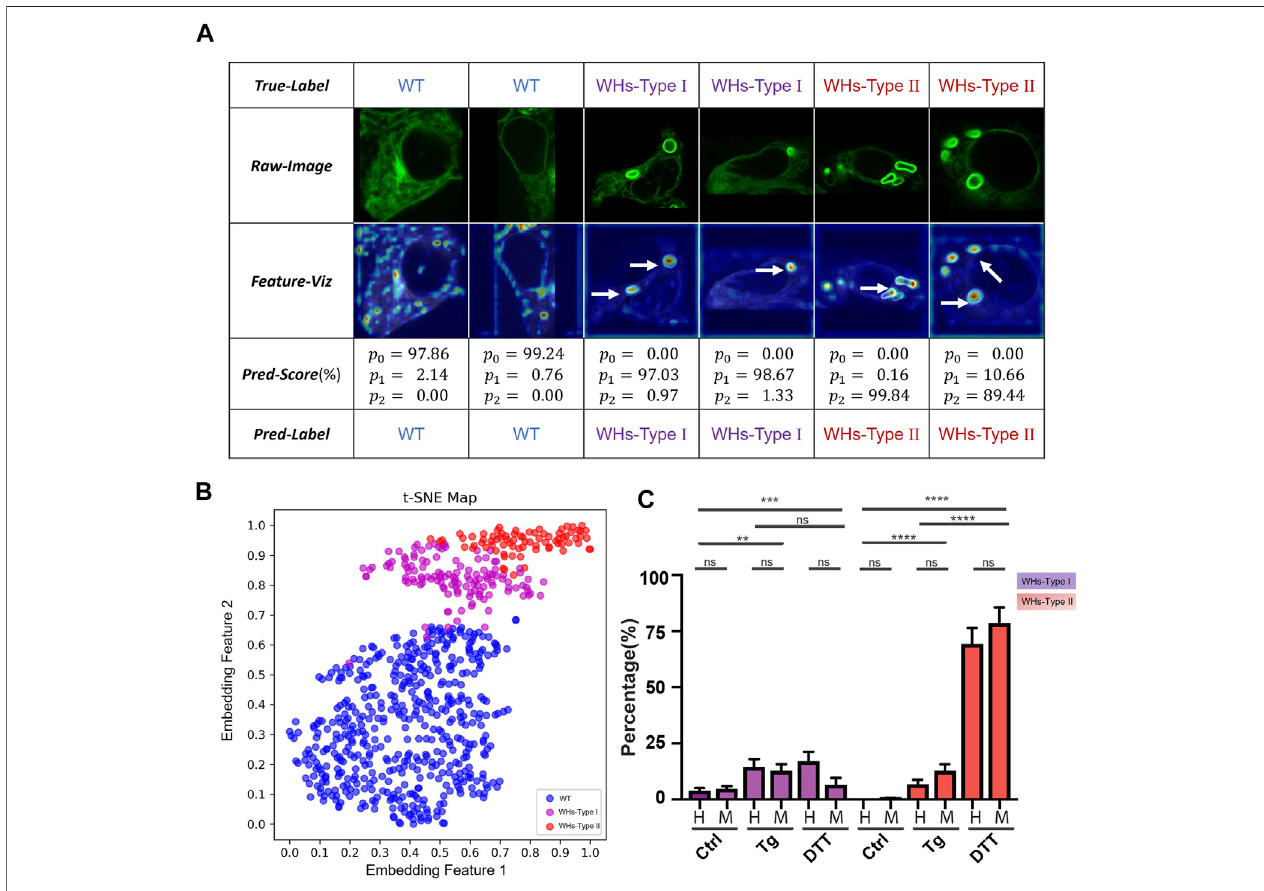
FIGURE 6 | Two sub-phenotypes of ER whorls were identi fi ed by ER-WHs-Analyzer-v2. (A) Results of images from the ER-Stress-B dataset processed by ER- WHs-Analyzer-v2, including the raw images, their corresponding feature heat maps, their prediction scores, and their predicted labels. (B) Based on the phenotypic features learned, a t-SNE map was used to visualize the distribution of wildtype ER images (WT), the ER images with WHs-Type I, and the ER images with WHs-Type II. (C) Double-blind testing results between human experts (H) and ER-WHs-Analyzer v2 (M). Purple bars show the distribution of WHs-Type I. Red bars show the distribution of WHs-Type II. Error bars indicate SEM, which was computed from 81 sampled images. **: p < 0.01; ***: p < 0.001; ****: p < 0.0001, ns: not signi fi cant.